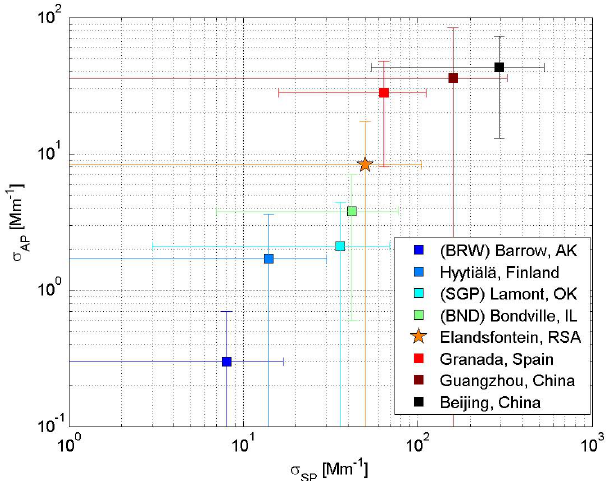
Fig. 10. Absorption coefficient as a function of scattering coef- ficient for different location: Barrow, USA (Delene and Ogren, 2002), Hyyti¨al¨a, Finland (Virkkula et al., 2011), Lamont, USA (De- lene and Ogren, 2002), Bondville, USA (Delene and Ogren, 2002), Elandsfontein, South Africa (this study), Granada, Spain (Lyamani et al., 2008), Guangzhou, China (Garland et al., 2008), Beijing, China (Garland et al., 2009). Error bars represent standard devi- ation, negative values are not shown.